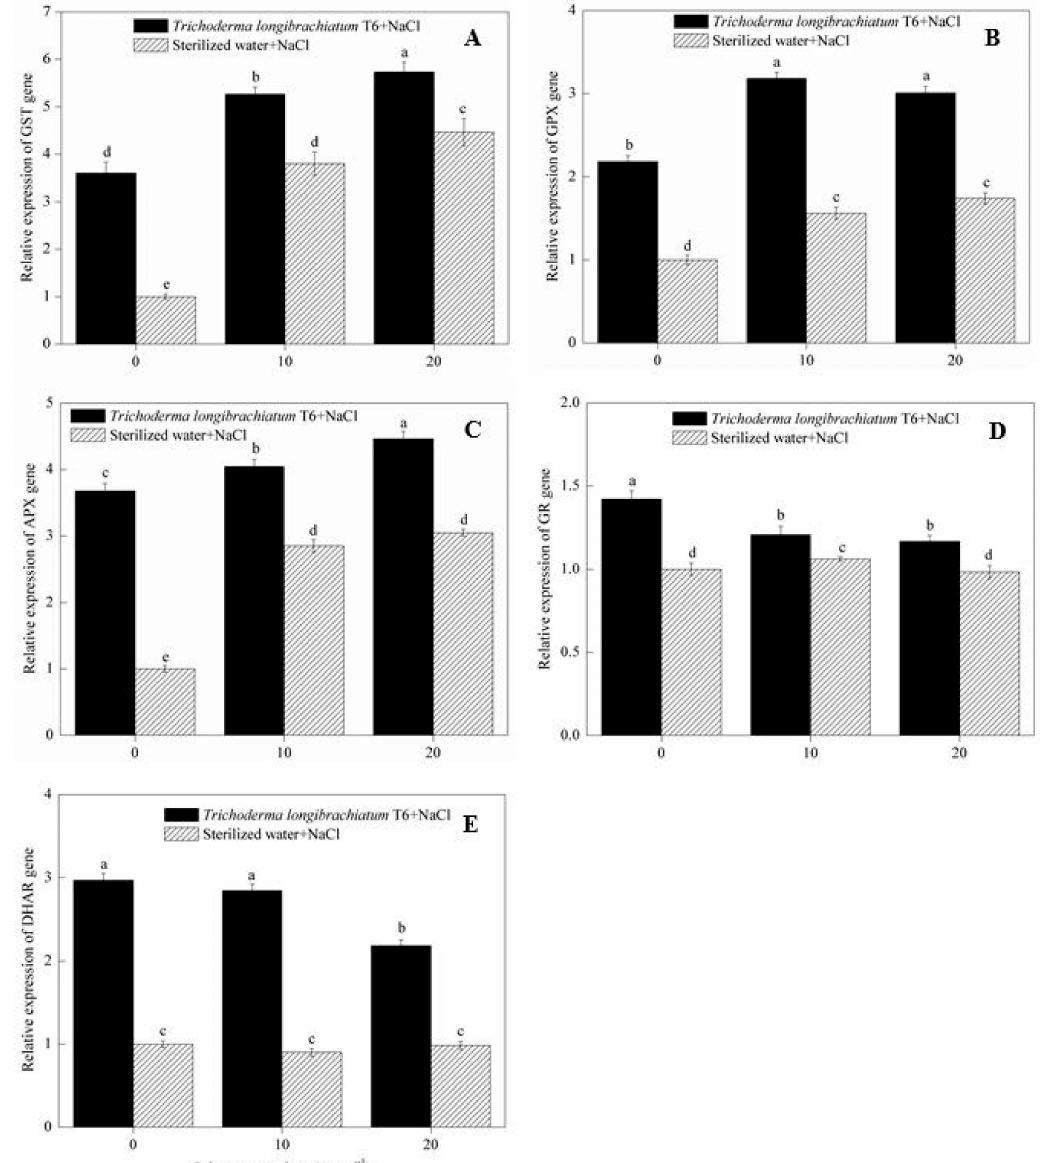
Figure 3. E ff ect of Trichoderma longibrachiatum T6 on the expression of ( A ) GST, ( B ) GPX, ( C ) APX, ( D ) GR and ( E ) DHAR genes in wheat seedling leaves under salt stress. The line bars represent the standard errors of the means. Di ff erent letters denote significant di ff erence at the p < 0.05 level by Duncan’s new multiple range test (n = 12). The treatments are detailed in the footnote of Table